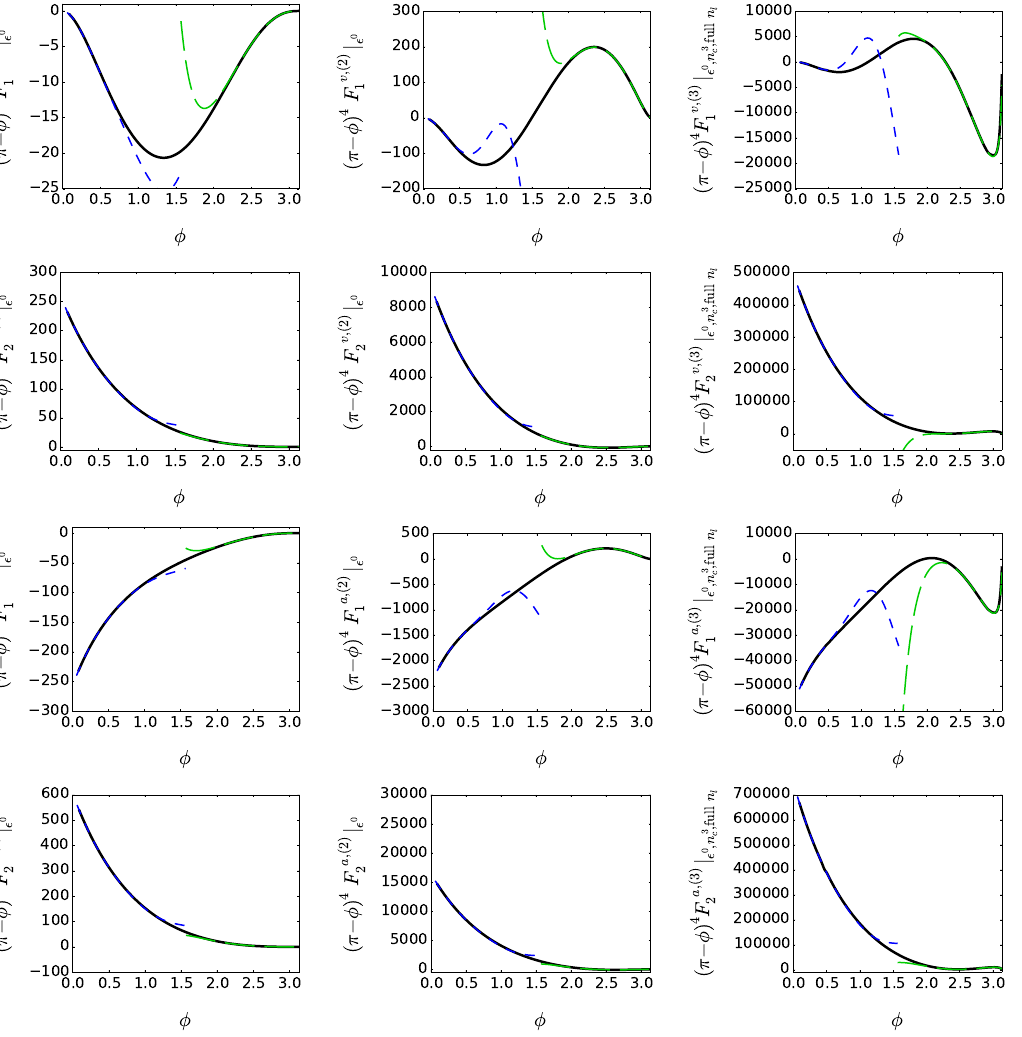
Figure 5 . ǫ 0 term of the vector and axial-vector form factors as a function of φ . Exact results and approximations are shown as solid and dashed lines, respectively. At three-loop order we add the complete light-fermion part for n l = 5 and the N 3 c contribution. Note that for φ form factors are real. Short- (blue) and long- (green) dashed lines correspond to the low-energy and threshold approximation,